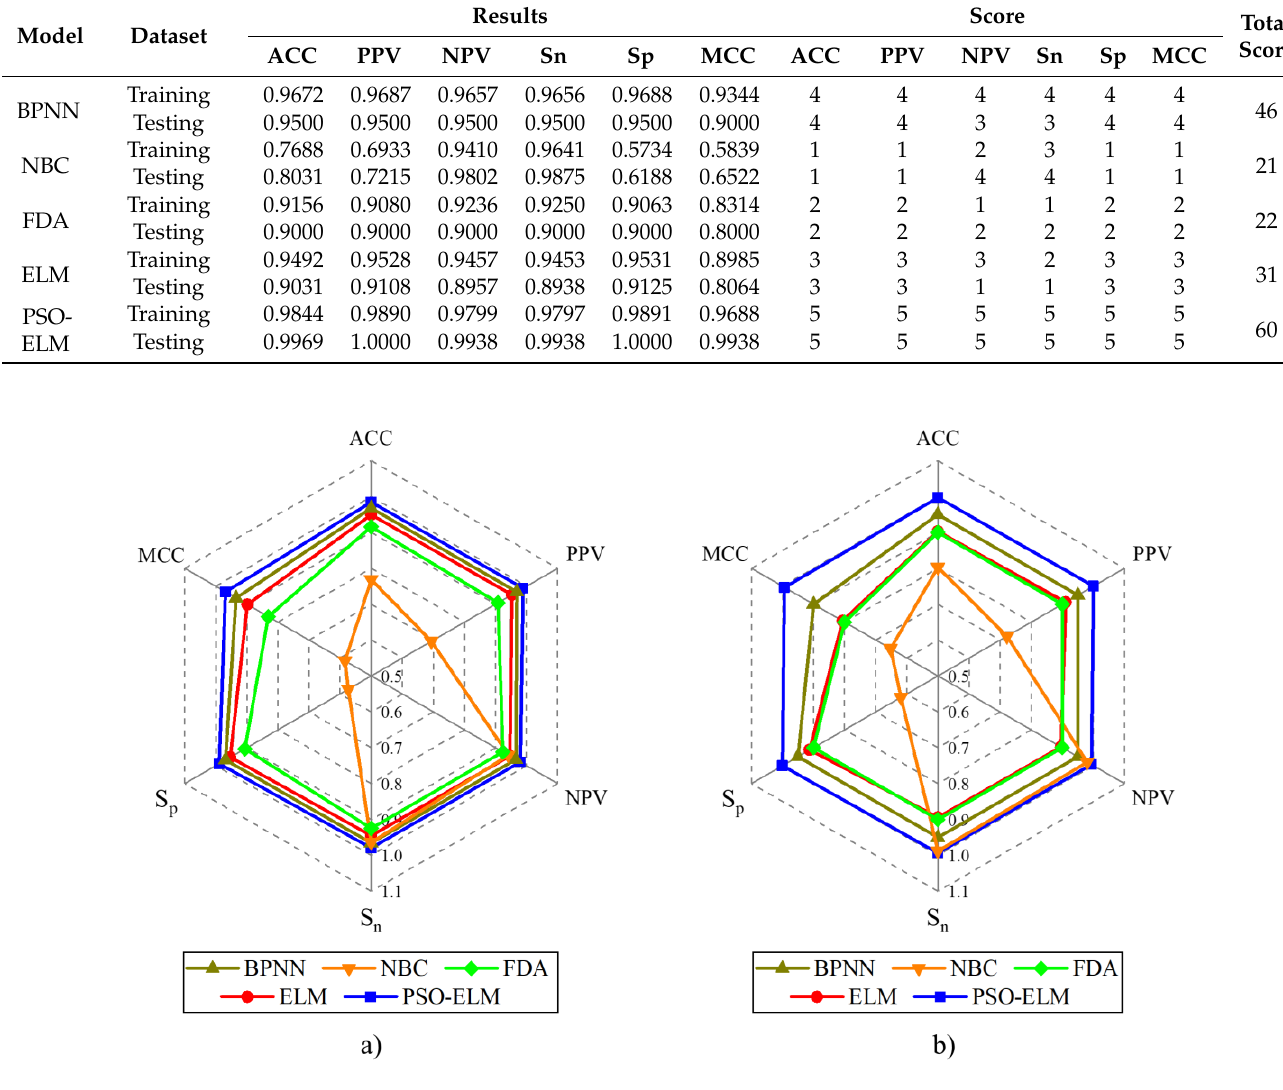
Figure 11. Discrimination results for different discrimination models. ( a ) the training set; ( b ) the testing set.